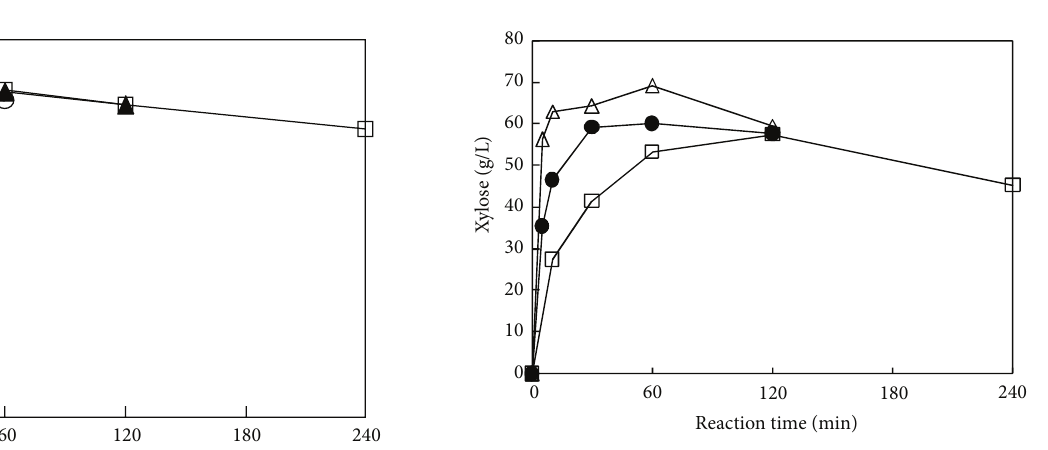
Figure 3: Time courses of xylose yield at different acid concentra- tions. ◻ : 1.5% (w/v) H 2 SO 4 and 0.6% (w/v) H 3 PO 4 ; e : 2% (w/v) H 2 SO 4 and 0.8% (w/v) H 3 PO 4 ; 󳵻 : 2.5% (w/v) H 2 SO 4 and 1% (w/v) H 3 PO 4 . Other conditions: liquid to solid ratio 3mL/g, 130 ∘ C.